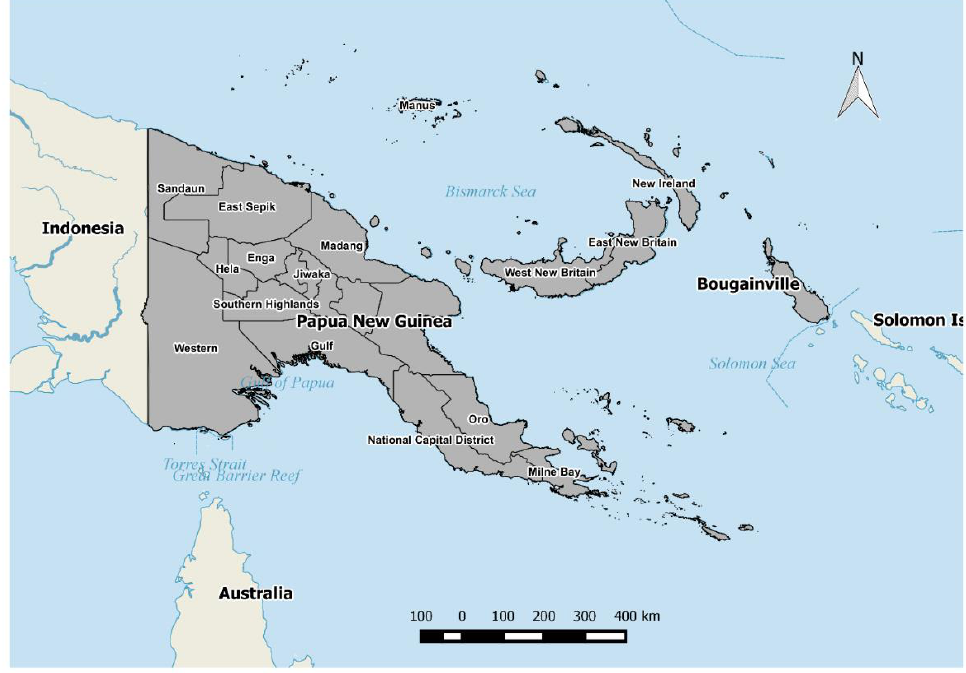
Figure 1. Map showing the study region,